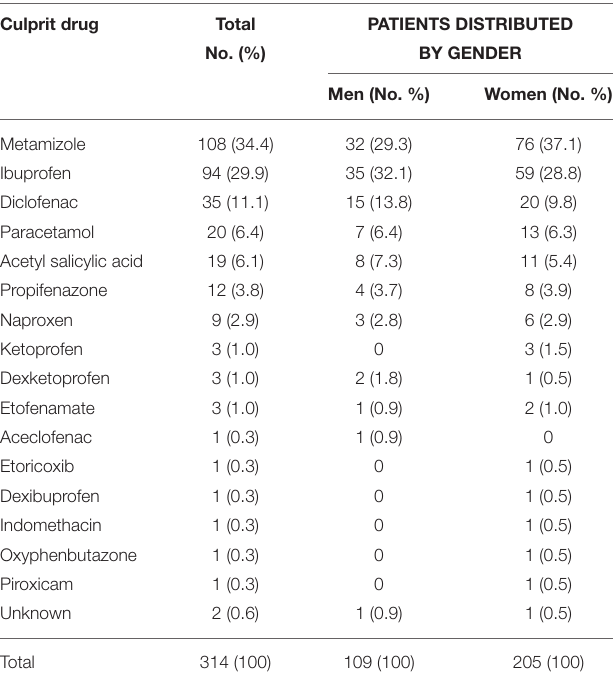
TABLE 2 | Culprit drug for selective NSAID-induced hypersensitivity. Culprit